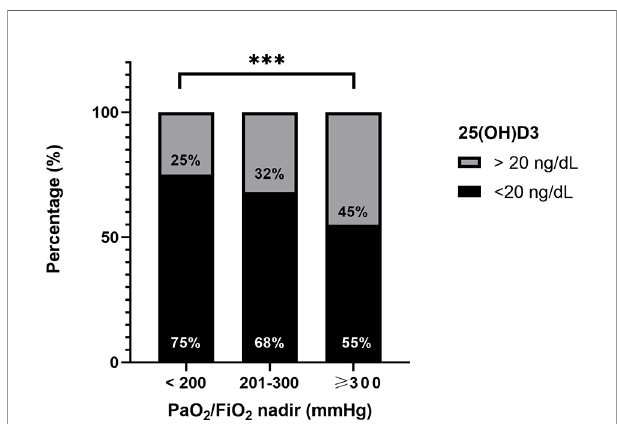
FIGURE 3 | Difference in proportion of patients with vitamin D insuf fi ciency (25OHD levels ≤ 20 ng/ml) among patients with PaO 2 /FiO 2 <200, 201 – 300, and ≥ 300 mmHg. ***p